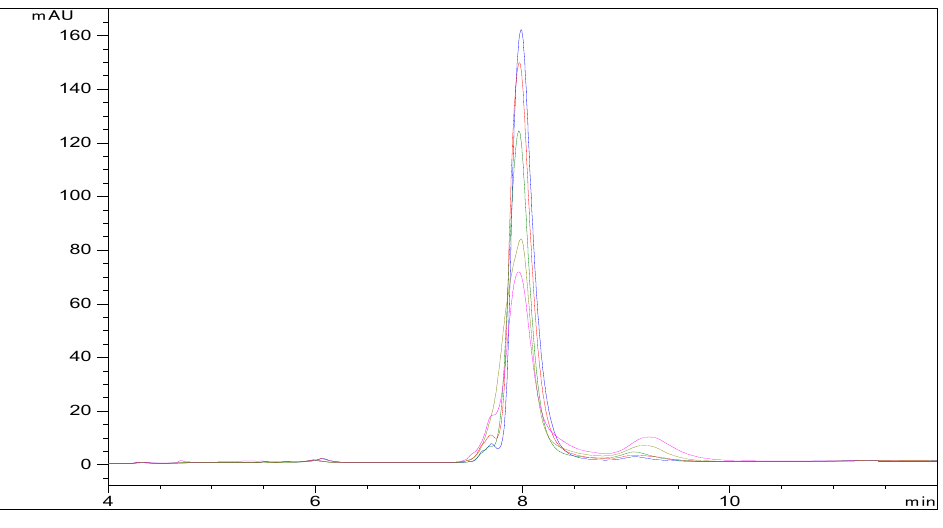
Figure A6. RP-HPLC chromatograms of Lf samples (optimized RP-HPLC method on a BioZen™ Intact XB-C8 column): −− control sample (thermal), −− thermal stress sample (T = 60 °C, t = 30 min), −− control sample (acidic and alkaline), −− acidic stress sample (0.1 M HCl, t = 3 days), and −− alkaline stress sample (0.01 M NaOH, t = 4 h).